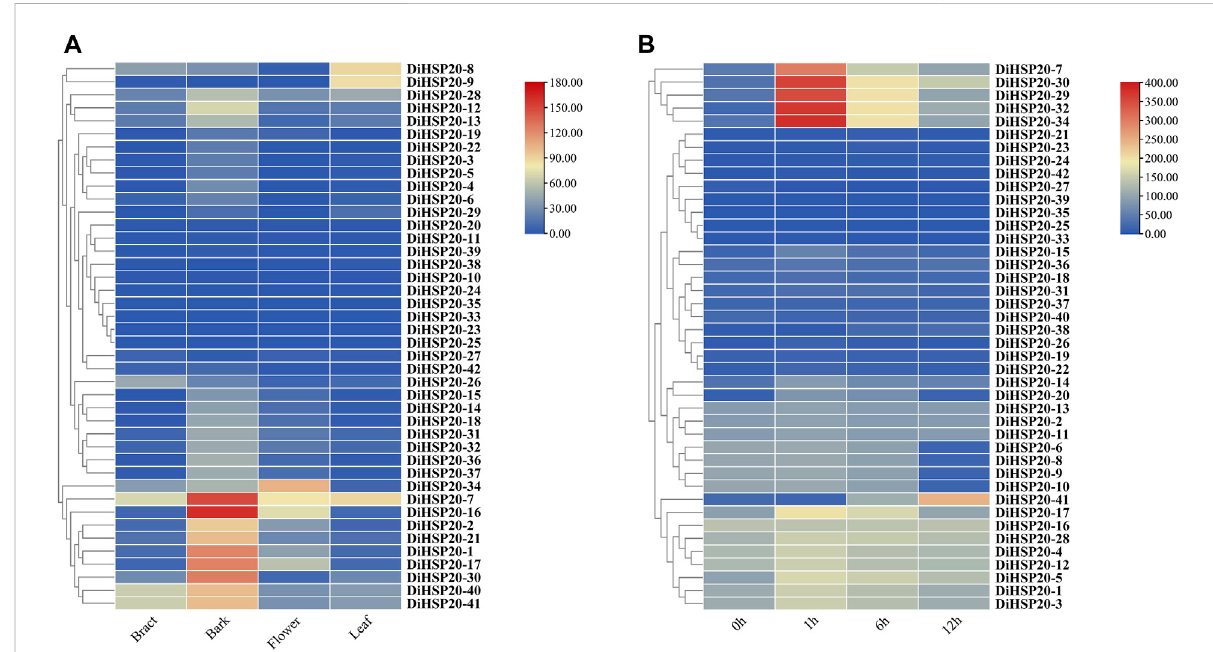
FIGURE 7 DiHSP20 gene expression in D. involucrata (A) Based on publically accessible transcriptome data, the transcript levels of the DiHSP20 genes in four tissues of D. involucrata were studied. From blue to red, the color scale re fl ects increasing degrees of expressiveness. (B) Based on publically accessible transcriptome data, the transcript levels of DiHSP20 genes in response to heat stress were studied.